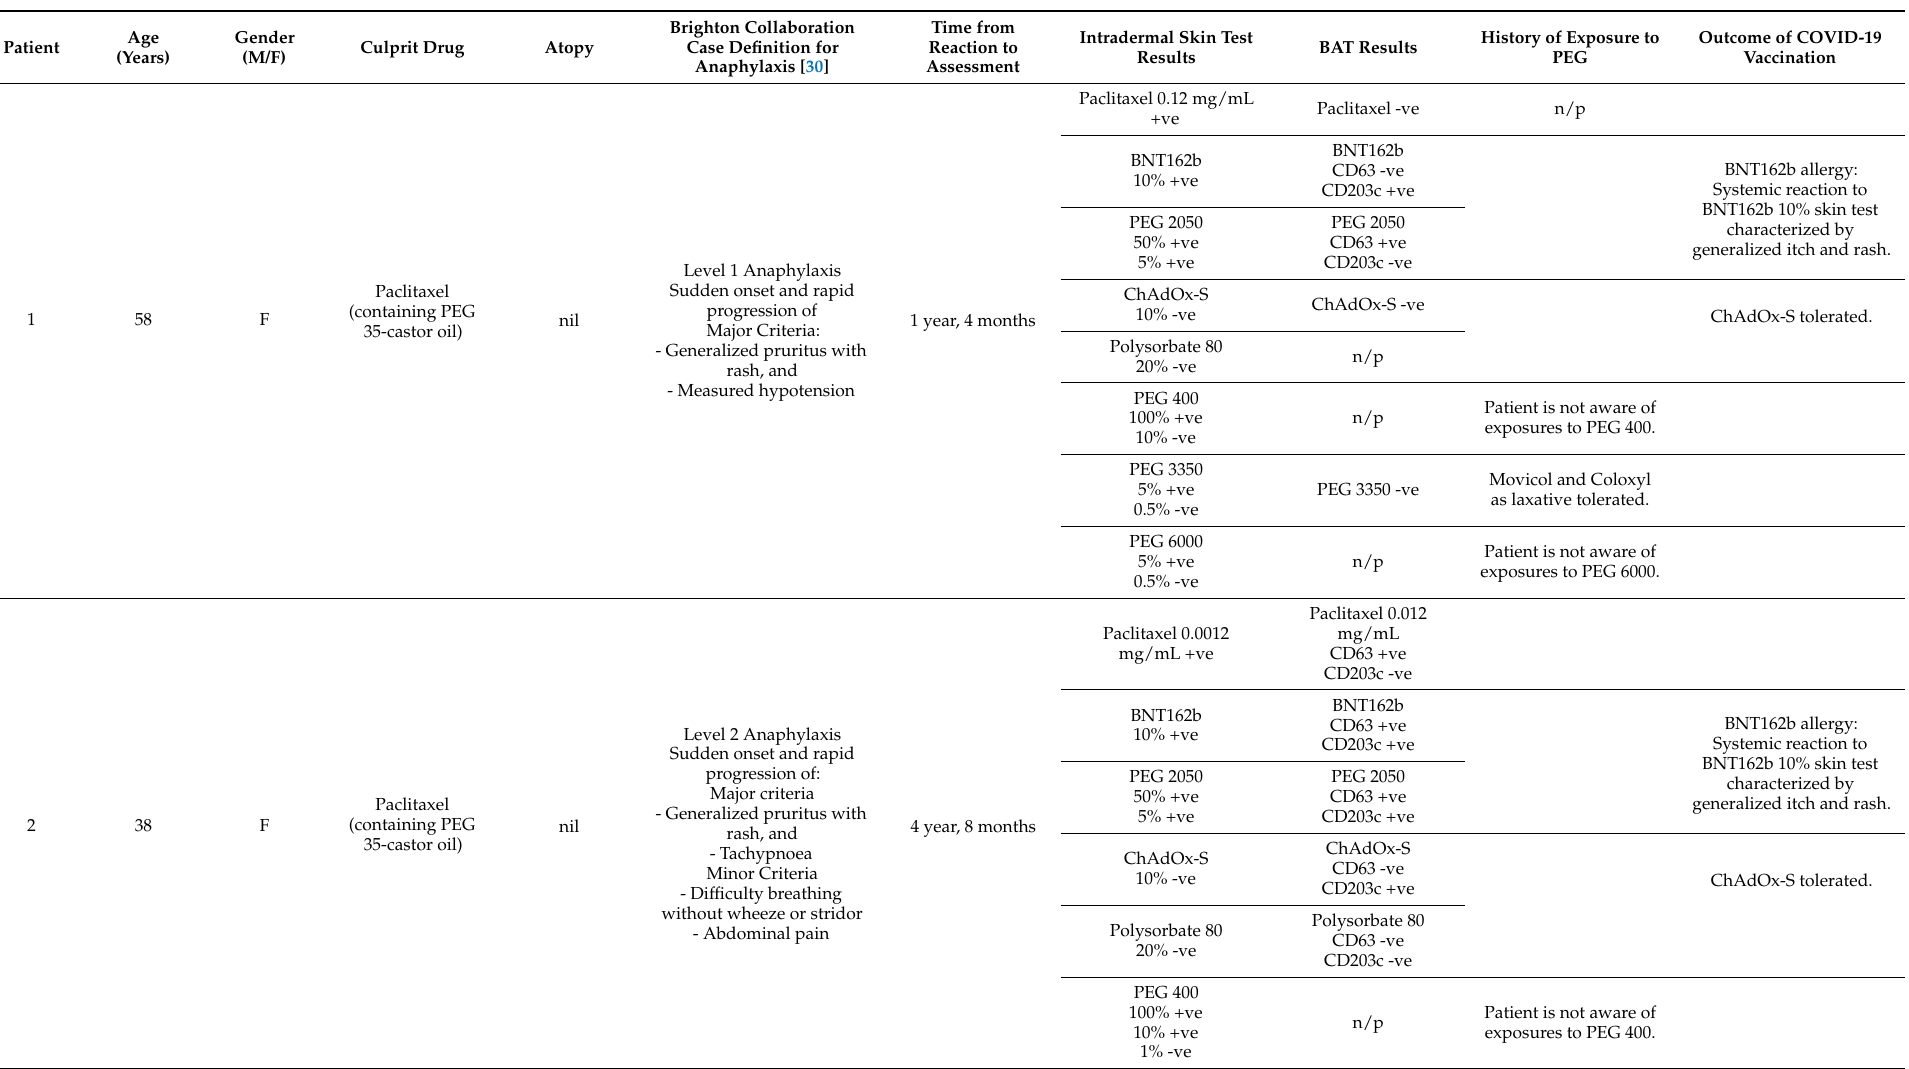
Table 2. Clinical Characteristics and Results of Intradermal Testing and Basophil Activation Testing in Allergic